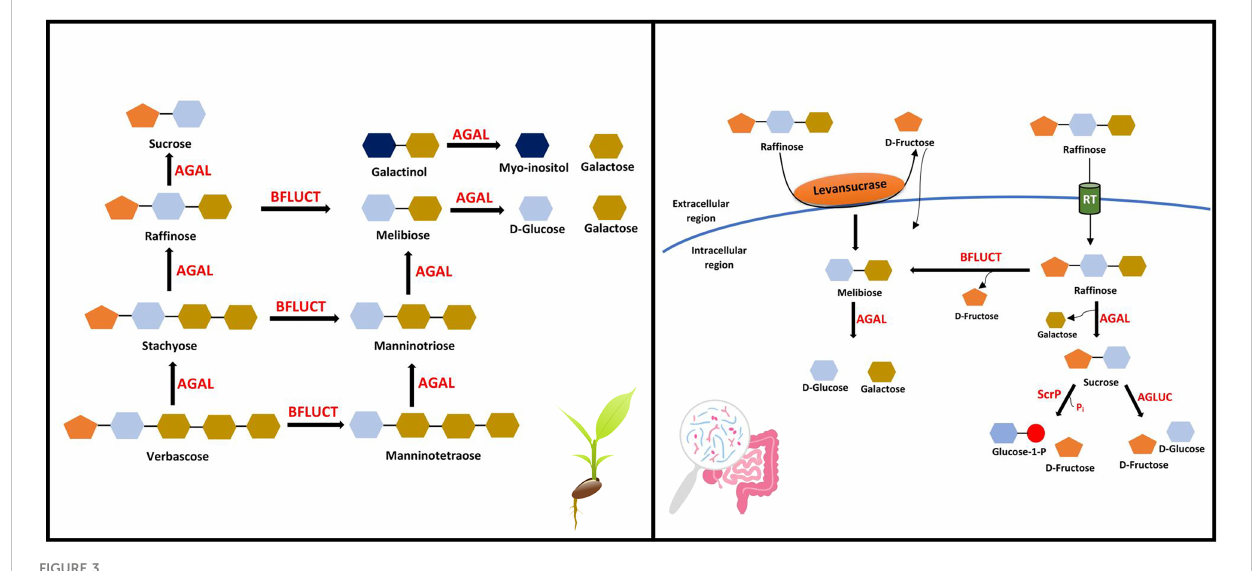
FIGURE 3 RFOs catabolism. RFOs are hydrolyzed by a -galactosidase (AGAL) and b -fructofuranosidase (BFLUCT) in most plants, producing simple sugars (left). RFOs utilization by gut microbiota in humans and animals via extracellular (levansucrases) or intracellular (raf fi nose transporter, RT) hydrolysis. AGLUC, a -glucosidases; ScrP, Sucrose